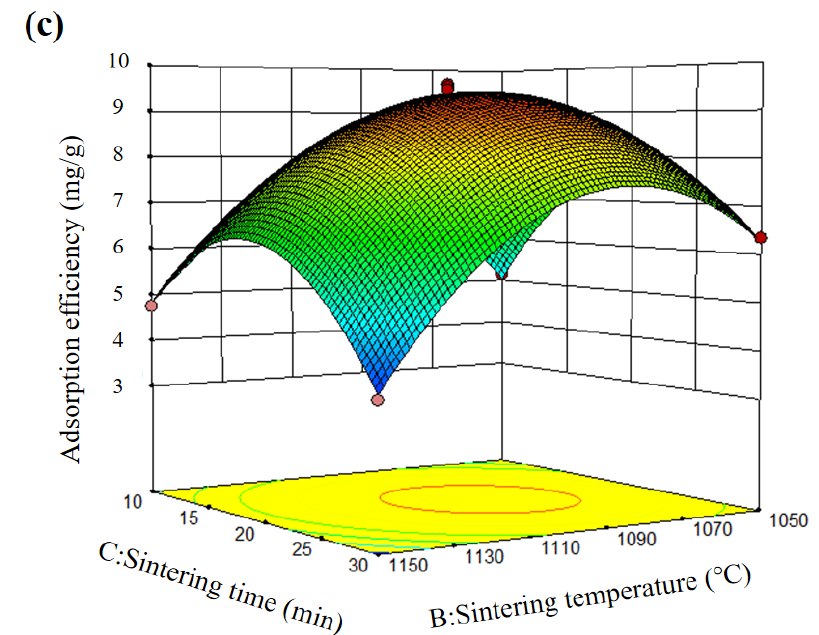
Figure 2. Response surface diagram of ( a ) A × B, ( b ) A × C, and ( c ) B × C.